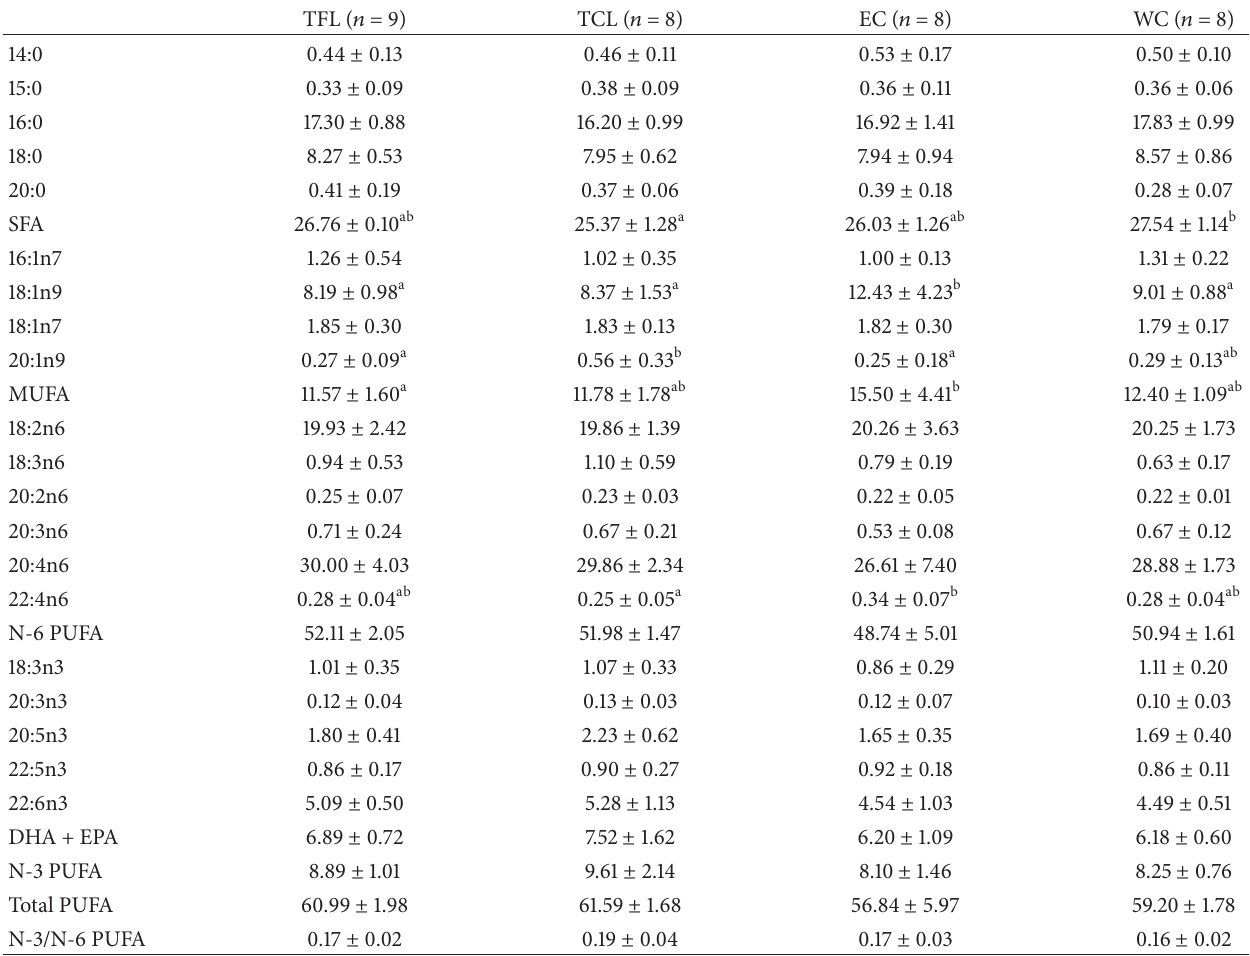
Table 4: Plasma total fatty acid profiles after consumption of TFL and TCL.